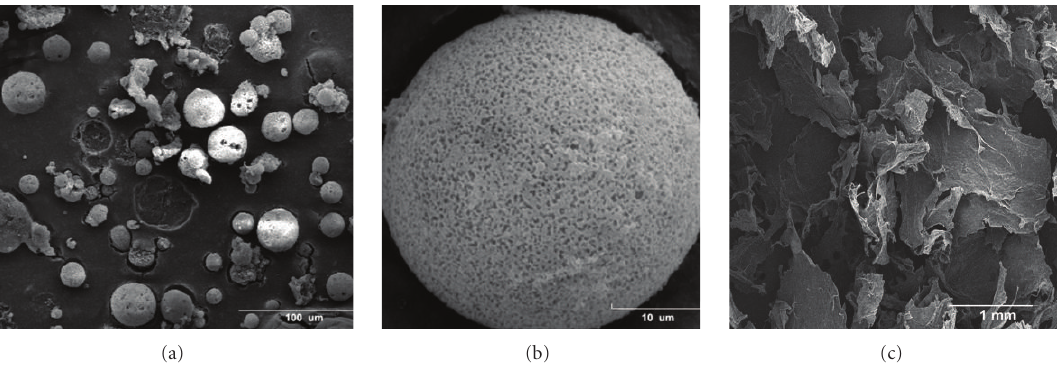
Figure 1: SEM micrograph of microparticles (a) (200x) and (b) (4000x) prepared with emulsification and cross-linking method; (c) prepared by ionic gelation method.